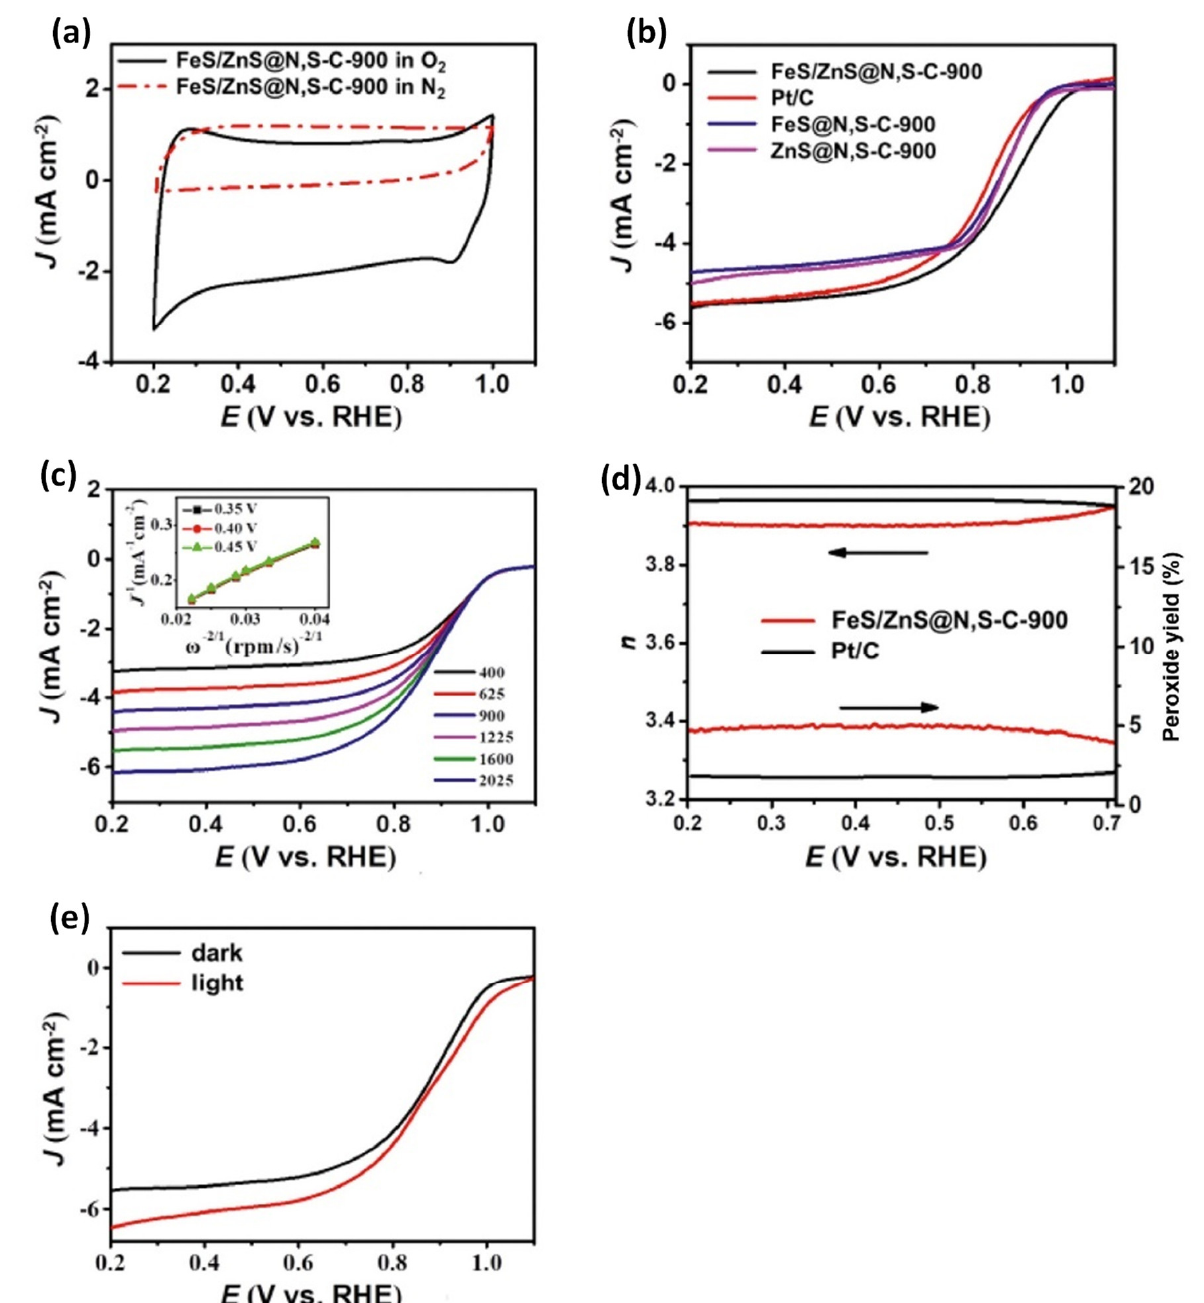
Figure 11. ( a ) CVs of FeS and ZnS incorporated in N, S-doped carbon derived from Sichuan pepper (FeS/ZnS@N,S-C-900) in N 2 and O 2 -saturated 0.1 M KOH electrolyte; ( b ) LSV curves of the original FeS/ZnS@N,S-C-900, the catalyst prepared without ZnS (FeS@N,S-C-900) or FeS (ZnS@N,S-C-900), and commercial Pt/C; ( c ) LSV curves of FeS/ZnS@N,S-C-900 at different rotation speeds with the corresponding K-L plots; ( d ) number of electron transferred per O 2 molecule and H 2 O 2 yield at the potential window of 0.2–0.7 V vs. RHE; and ( e ) LSV curves of FeS/ZnS@N,S-C-900 obtained in dark conditions or under light irradiation in O 2 -saturared 0.1 M KOH electrolyte (1600 rpm, 10 mV s − 1 ). Reprinted from [186], Copyright (2020), with permission from